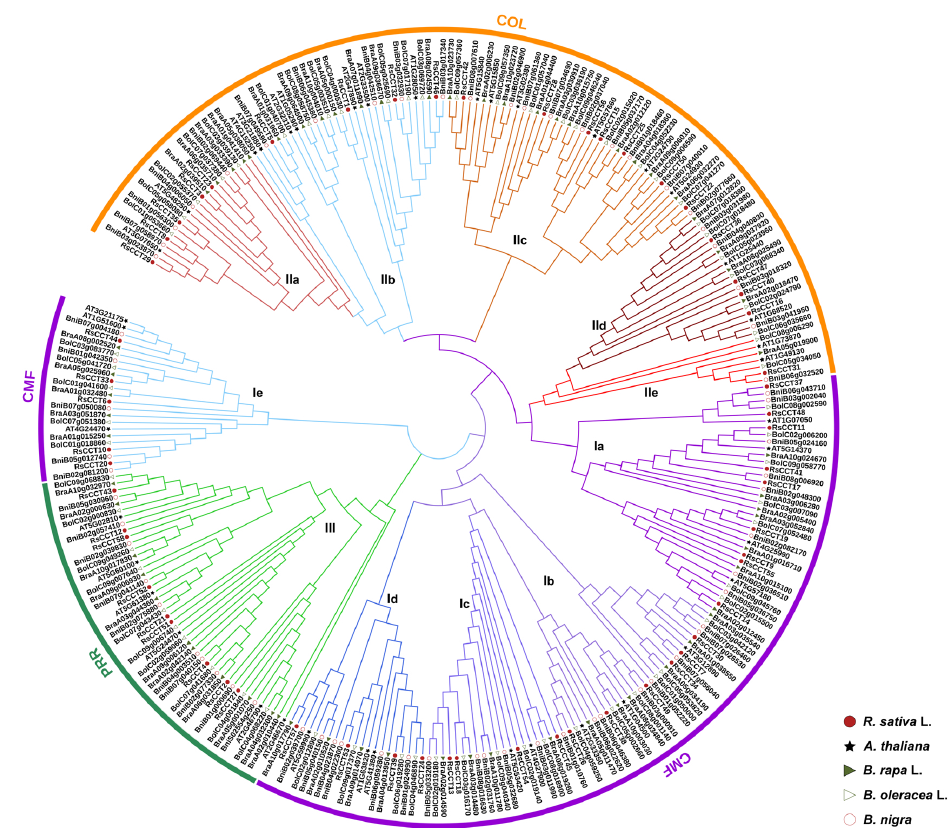
Figure 2. Phylogenetic relationships among CCT motif family genes in A. thaliana , B. rapa , B. nigra , B. oleracea, and R. sativus . The phylogenetic tree was constructed using MEGA7.0, and the bootstrap was 1000 replicates. The gene names were shown in Supplementary Table S4. The different colors of the circle represented proteins of different